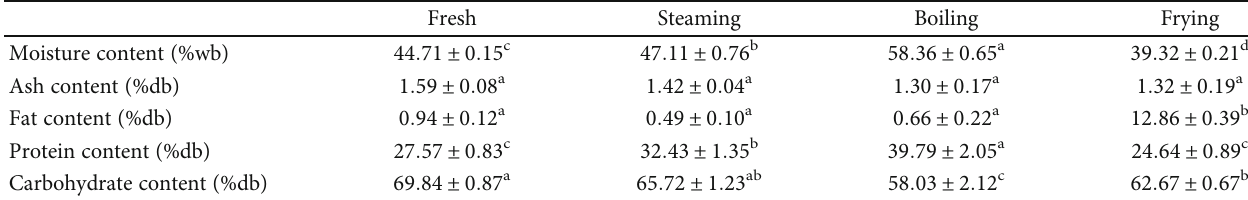
Table 2: The nutrition components of Kabau on di ff erent conventional processing techniques. Fresh Steaming Boiling